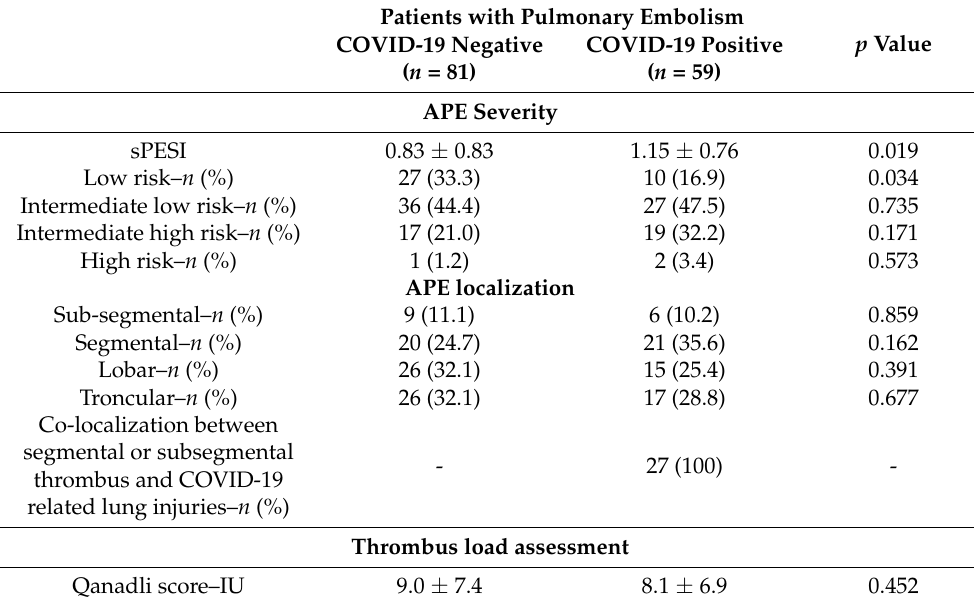
Table 2. Characteristics of acute pulmonary embolism stratified by the presence or absence of COVID-19. Patients with Pulmonary